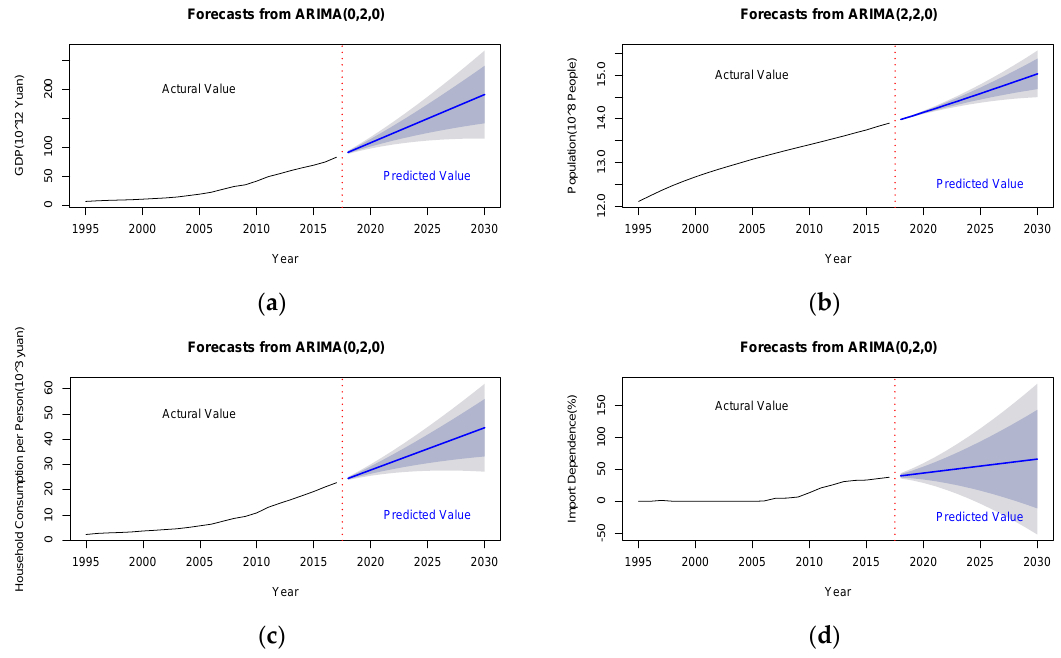
Figure12. Natural gas core influencing factors prediction curve, ( a ) Forecasting of GDP; ( b ) Forecasting of Population; ( c ) Forecasting of Household Consumption per Person; ( d ) Forecasting of Import Dependence.